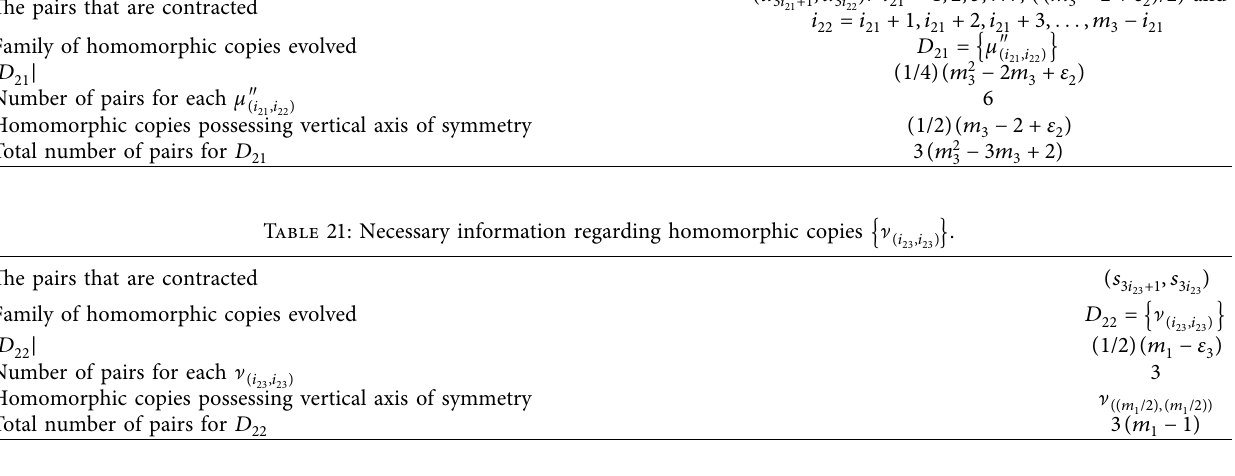
Table 20: Necessary information regarding homomorphic copies μ